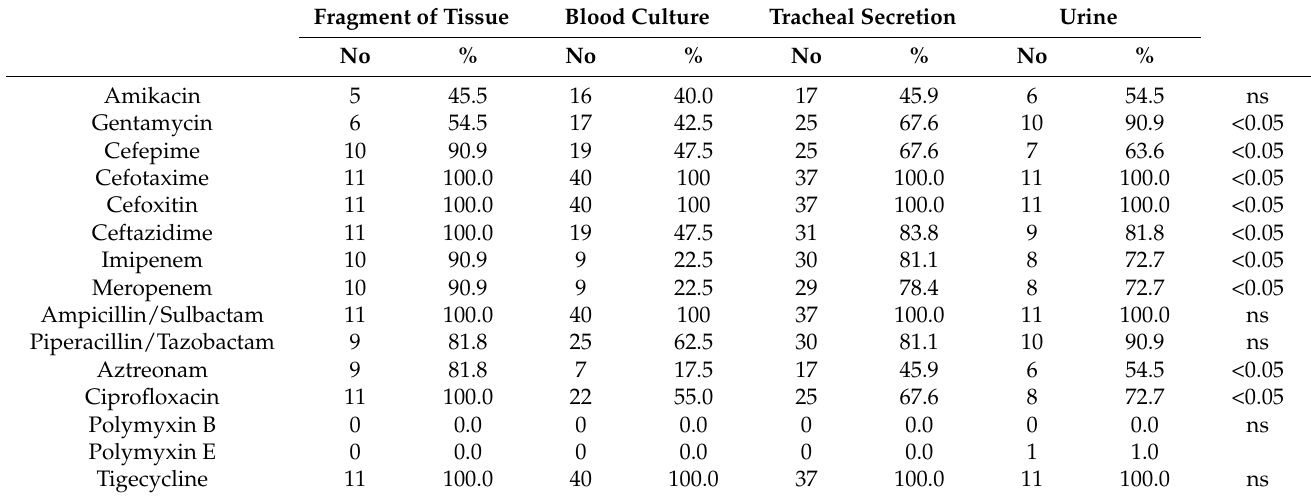
Table 5. Antimicrobial resistance profile of Pseudomonas aeruginosa isolates by infection site. Fragment of